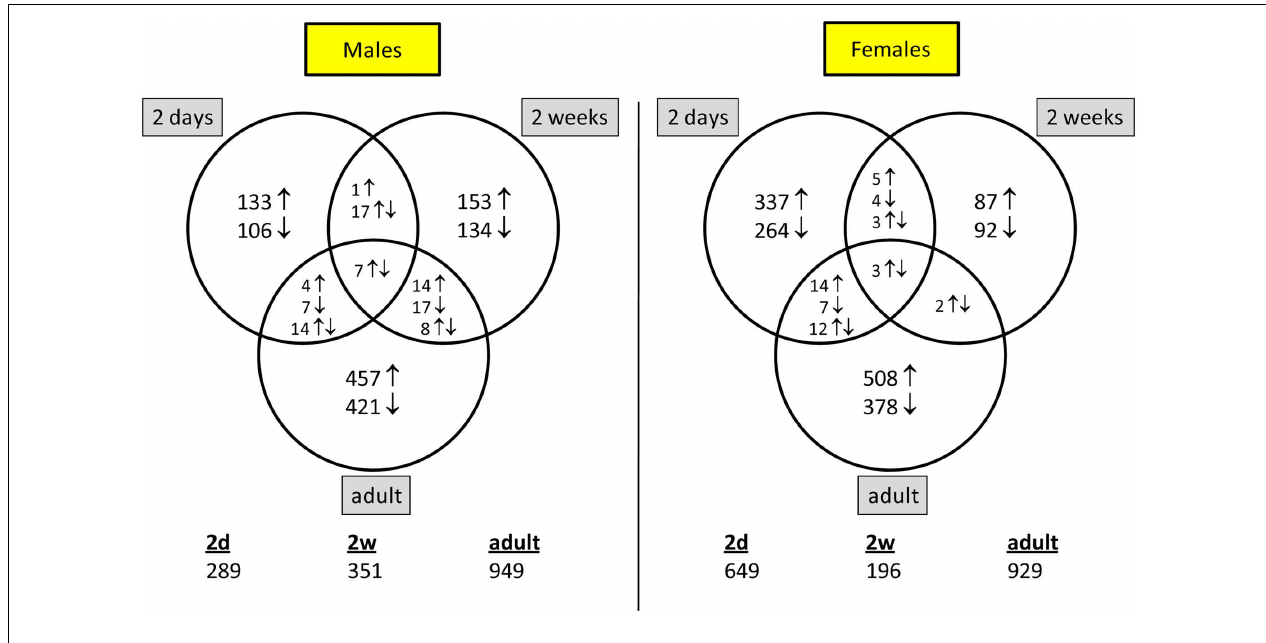
and down arrows indicate genes that are differentially induced or reduced by molsidomine vs. control, respectively. Below the diagram are the total numbers of genes that are differentially expressed by molsidomine vs.